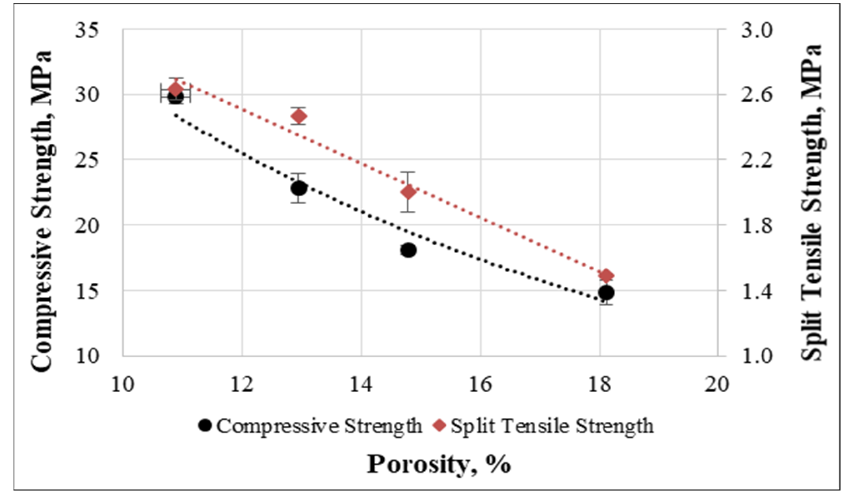
Figure 26. Relationship between porosity, compressive and split tensile strengths.